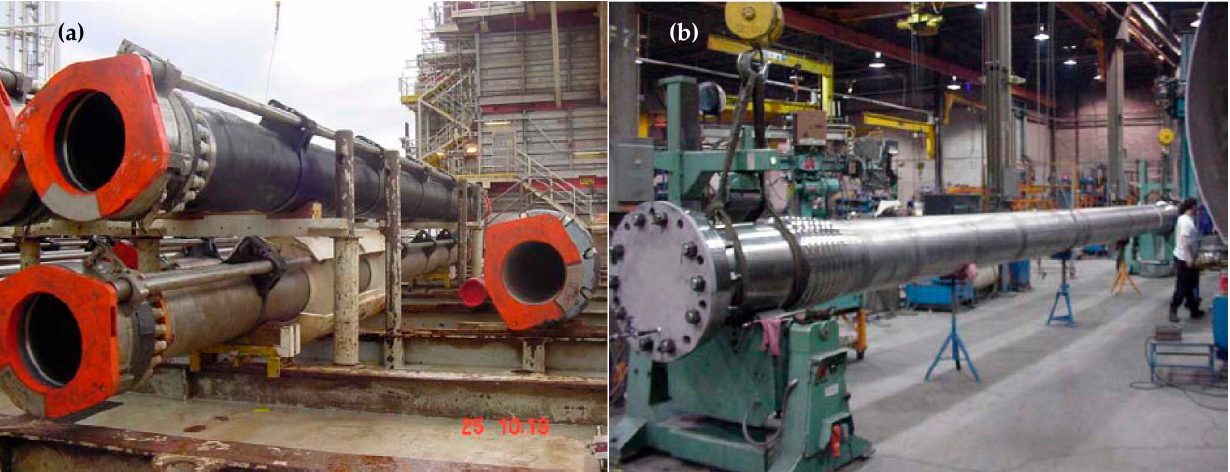
Figure 2. The stack of Norske Conoco AS and Kvaerner Oil Field Products (NCAS/KOP) composite drilling risers (CDR) which held the first composite riser joint (CRJ) for Heidrun Platform with an assembly of titanium liner connector. ( a ) CDR Joint Located Over Titanium Drilling Riser Joint, and ( b ) Titanium Liner-Connector Assembly of NCAS/KOP Composite Drilling Riser (Courtesy: OTC’s OnePetro Publisher; Norske Conoco AS; and Kvaerner Oil Field Products; Sources: